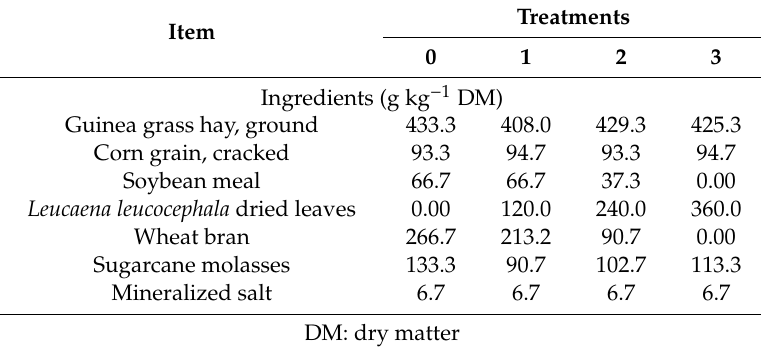
Table 1. Ingredient composition of experimental diets.